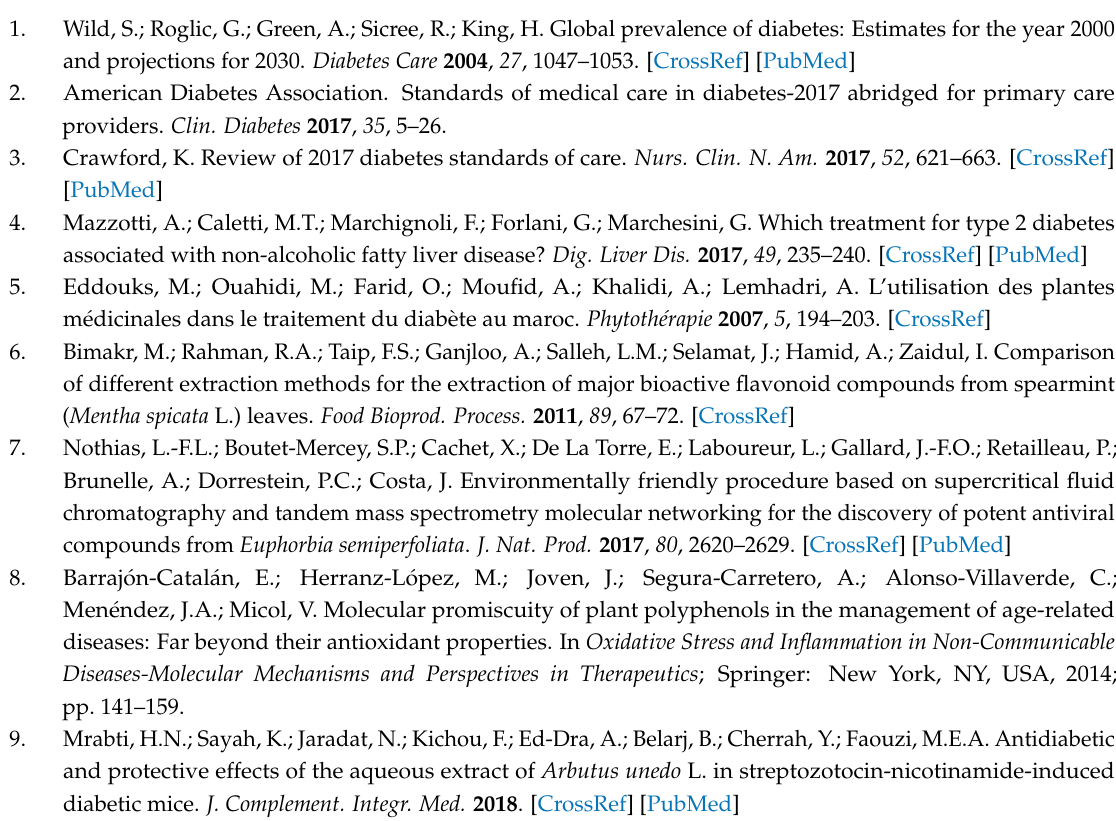
Figure S1: 1 H NMR spectra analysis, Figure S2: 1 H NMR spectra analysis, Figure S3: 1 H NMR spectra analysis, Figure S4: 13 C NMR spectra analysis, Figure S5: 13 C NMR spectra analysis, Figure S6: 13 C NMR spectra